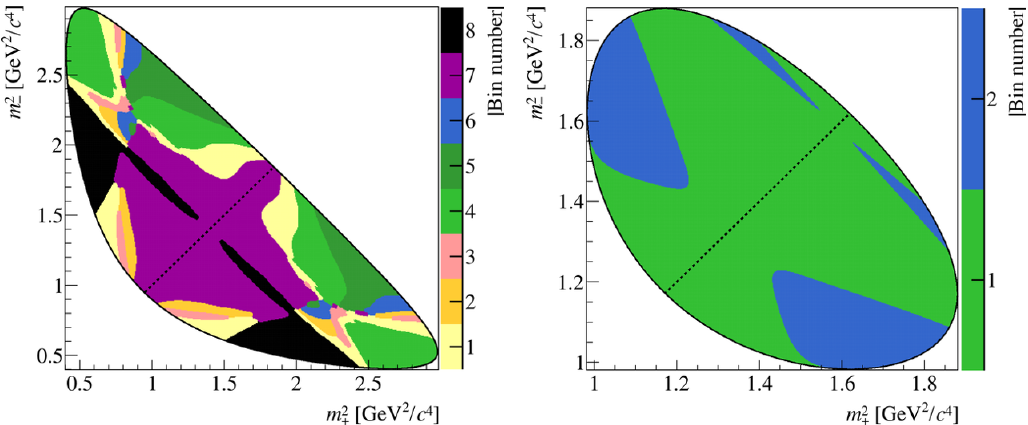
Figure 1 . Binning schemes for (left) D ! K 0 The diagonal line separates the positive and negative bins, where the positive bins are in the region in which m 2 > m 2 is (cid:0) +